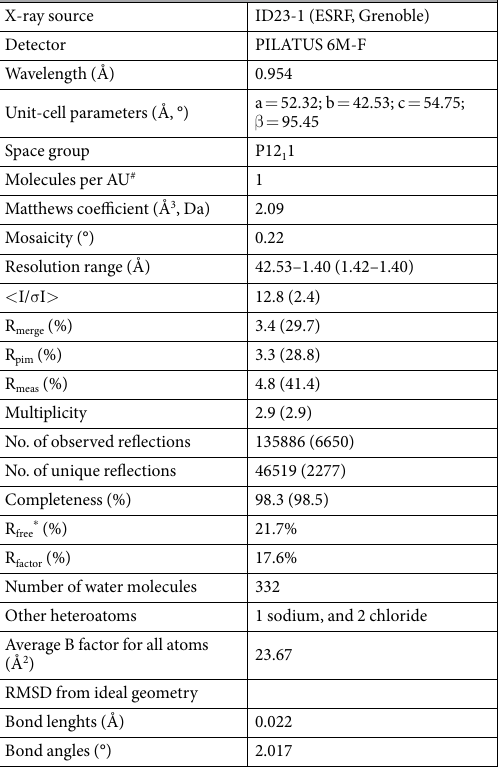
Table 4. Data collection, processing and structure refinement statistics for TupA crystal. Values in parentheses correspond to the highest resolution shell. # AU: asymmetric unit. * R free was calculated for 5.1% of the reflections randomly chosen from the data